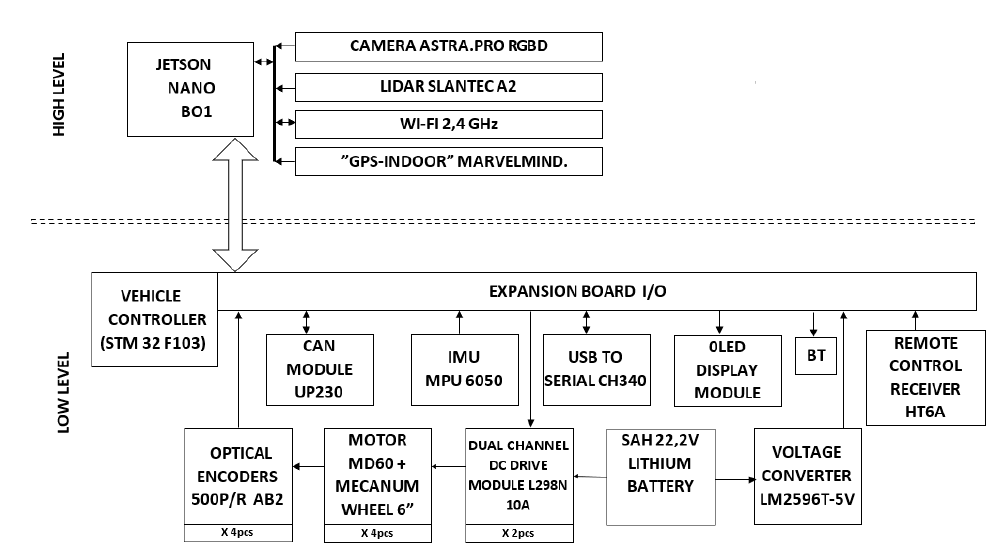
Figure 2. Layered hardware architecture of the